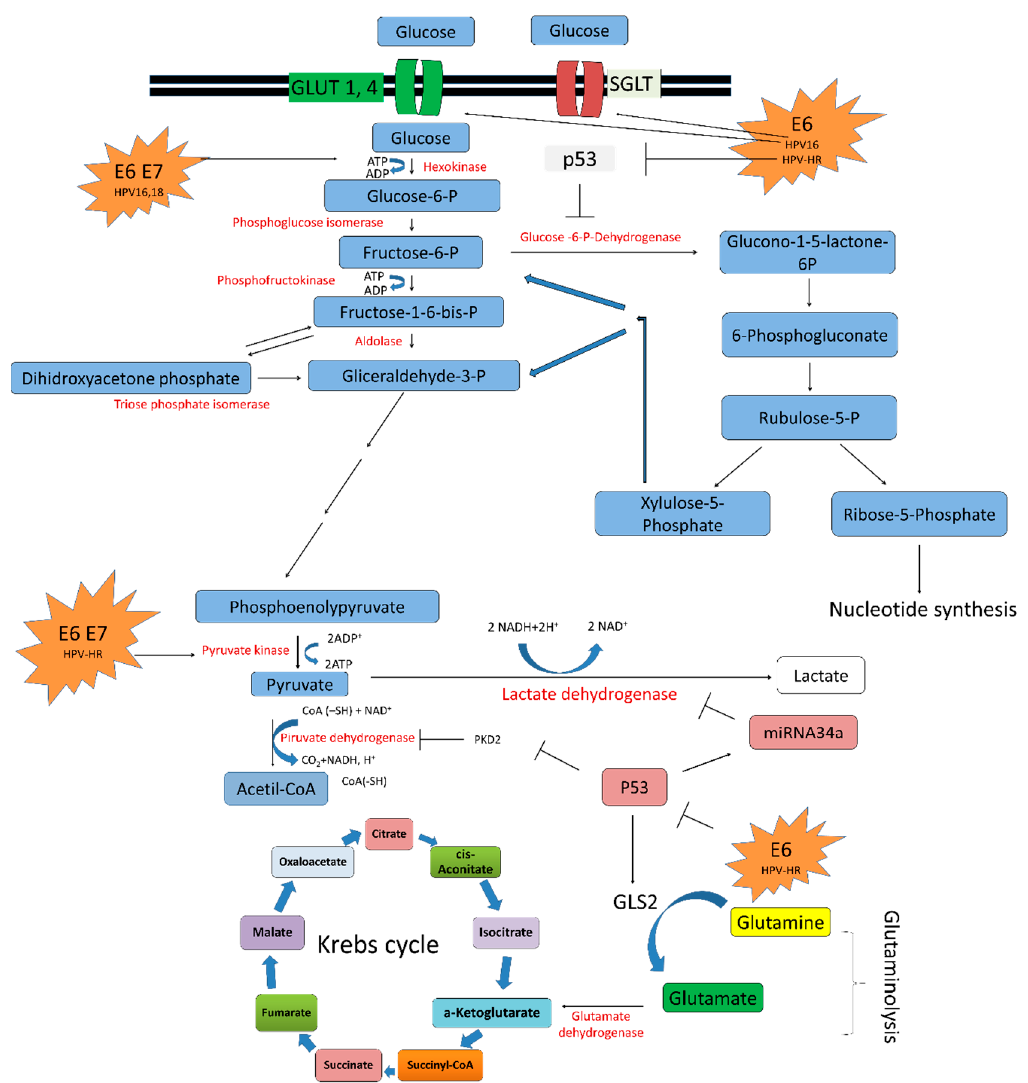
Figure 4. The modulation of glucose metabolism by HPV oncoproteins favor glycolysis instead of OXPHOS. HR-HPV E6 oncoproteins promote glucose uptake through the overexpression of glucose transporters GLUT and SGLT. Both E6 and E7 oncoproteins induce the expression of hexokinase, enzyme associated to the first step of glucose metabolism. Moreover, E6 can promote nucleotide synthesis through the degradation of p53, which is an antagonist of glucose 6-P-dehidrogenase, a key enzyme in the pentose phosphate pathway (PPP). The glycolytic pathway is carried out in two phases. First, in the preparatory or glucose activation phase, a six-carbon glucose molecule breaks down into two molecules with three carbons each: one glyceraldehyde-3-phosphate and the other is dihydroxyacetone phosphate, which is transformed into glyceraldehyde-3-phosphate. In these reactions, two molecules of ATP are consumed. Second, the energy extraction phase, involves the conversion of the two glyceraldehyde-3-phosphate molecules into two pyruvate molecules by pyruvate kinase, which is activated by E6 and E7 oncoproteins. This process results in the production of four ATP molecules through substrate-level phosphorylation. Pyruvate is metabolized to acetyl-CoA by pyruvate dehydrogenase, which, in turn, is negatively regulated by pyruvate dehydrogenase kinase 2 (PDK2). PDK2 is activated in the absence of p53, a process induced by E6, avoiding acetyl-CoA production. Moreover, p53 degradation avoids glutaminase 2 (GLS2) activation and glutaminolysis, which in turn decreases α -ketoglutarate levels. Thus, E6 does not permit an optimal function of the Krebs cycle, inducing lactate production by lactate dehydrogenase. E6 prevents the expression of miRNA34a and lactate dehydrogenase deactivation. HPV type is indicated. T arrows indicate inhibition. Black line arrows and thick blue arrows indicate the direction of the reaction.